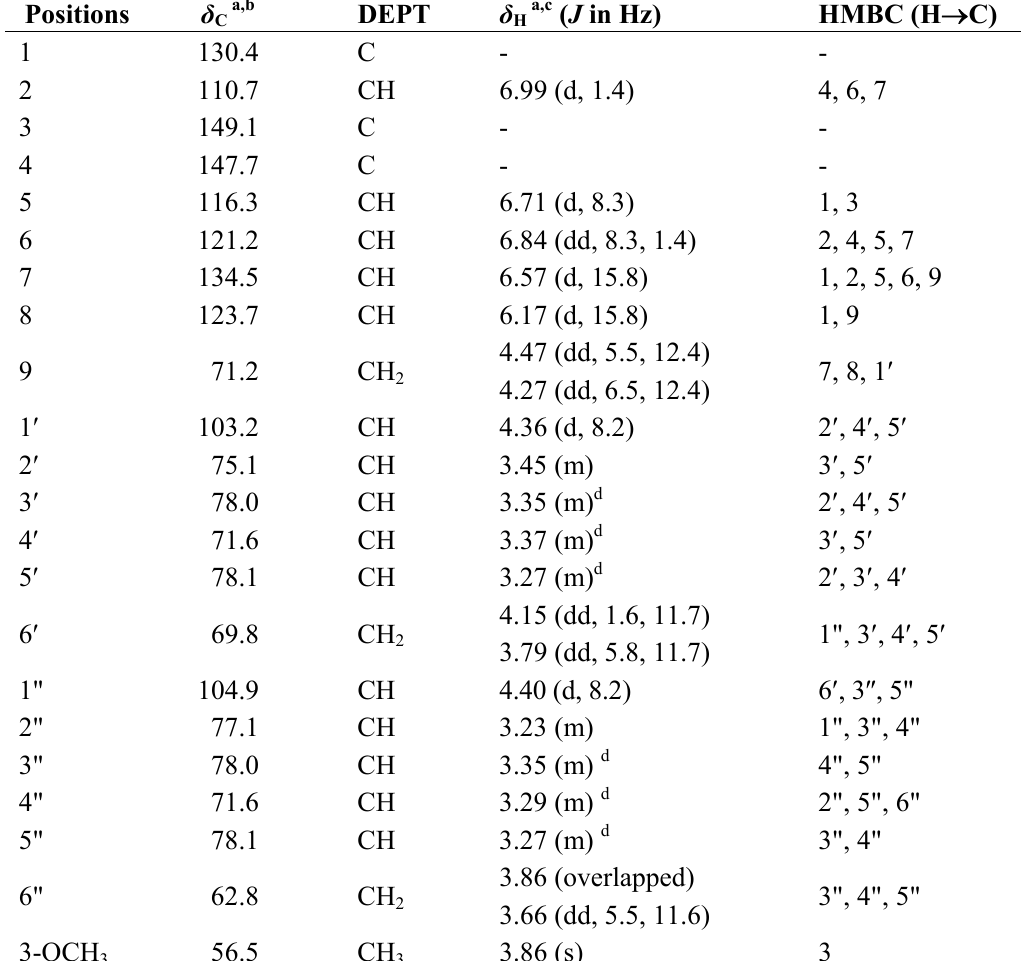
Table 1. 1 H and 13 C NMR Data for compound 1 in CD